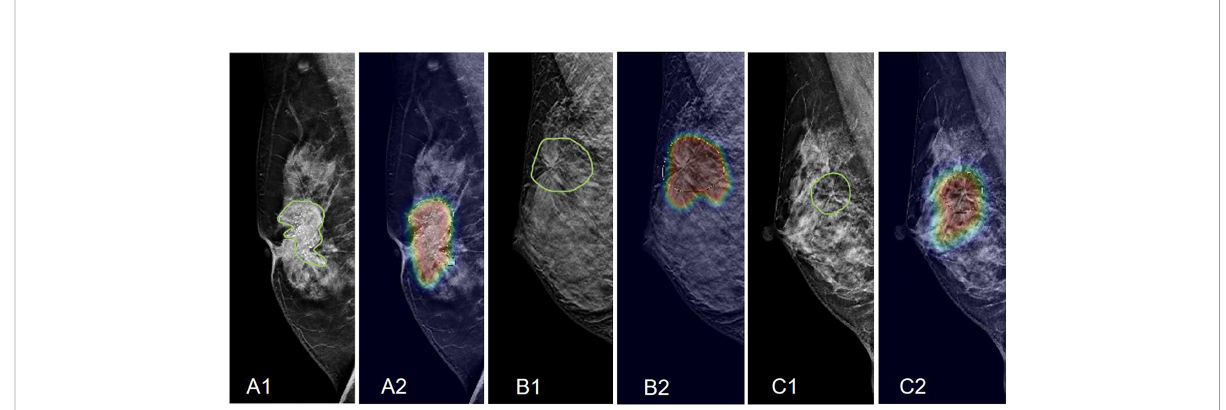
FIGURE 6 Examples of Grad-CAM maps of architectural distortion on DBT images, predicted by ResNet50 deep learning. (A) The RMLO view of a 61-year- old patient diagnosed with invasive ductal cancer. The BI-RADS score is 5. The radiomics score of the combined model is 0.72, and the probability predicted by deep learning is 0.54, both correctly diagnosing this case as malignant. (B) The RMLO view of a 42-year-old patient diagnosed with adenosis. The BI-RADS score is 4C. The radiomics score of the combined model is 0.48, and the probability predicted by deep learning is 0.52. The radiomics model makes a correct benign diagnosis, but deep learning gives a false-positive diagnosis. (C) The RMLO view of a 46-year-old patient diagnosed with fi broadenoma. The BI-RADS score is 4B. The radiomics score of the combined model is 0.41, and the probability predicted by deep learning is 0.51. The radiomics model makes a correct benign diagnosis, not deep learning. However, although deep learning does not give a correct diagnosis, it can localize the suspicious